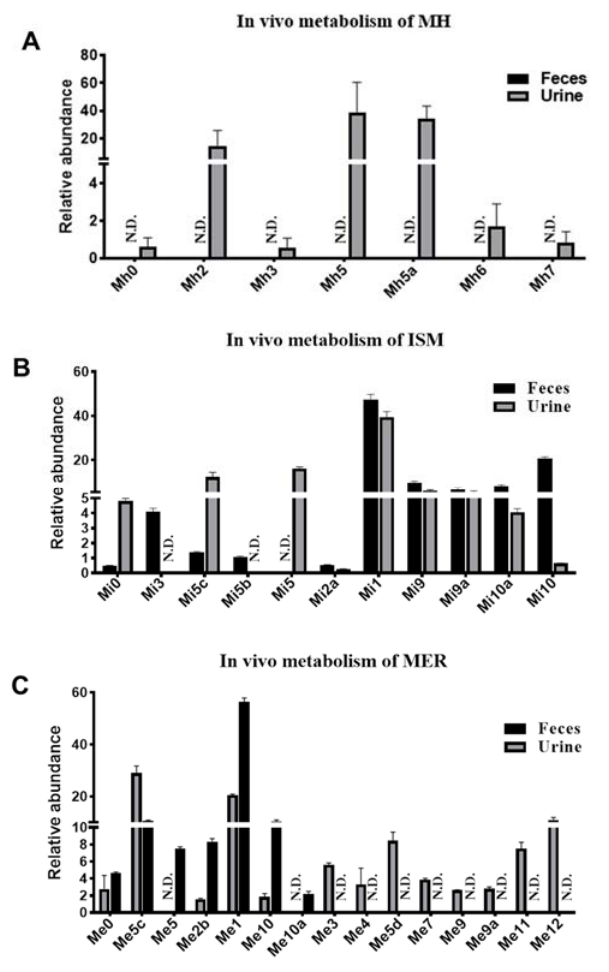
Figure 4. Metabolomics analysis of MH, ISM, and MER metabolites in mouse feces and urine. ( A ) Comparison of MH major metabolites in mouse feces and urine. ( B ) Comparison of ISM major metabolites in mouse feces and urine. ( C ) Comparison of MER major metabolites in mouse feces and urine. Table 1. Summary of MER metabolites produced in vivo and in vitro metabolism.